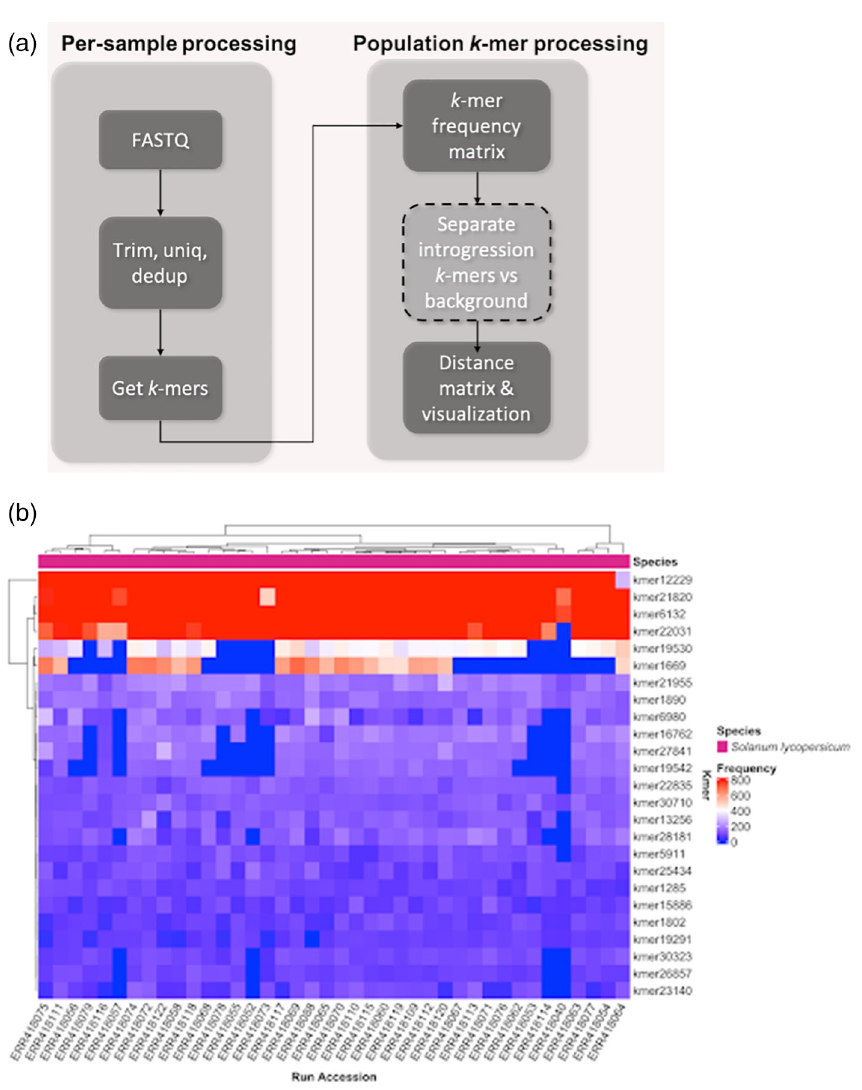
Figure 2. (a). kTom workflow, with major steps for individual sample and population data processing. (uniq = get unique reads; dedup = deduplicate reads). (b). k -mer frequency heatmap from kTom. Frequency of selected k -mers in each accession analyzed. Differential k -mer frequencies are apparent in this view. Depending on the nature of the accessions, this view may provide a first glimpse into genetic sequences underlying structural variations that differentiate the